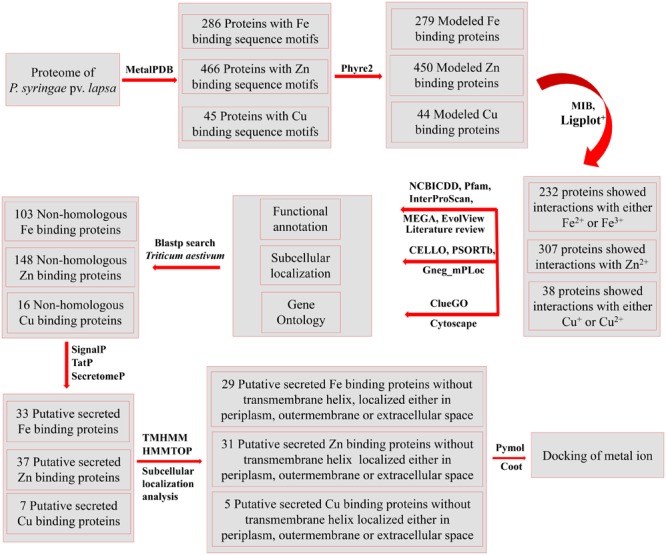
The overall methodology of the present study. The whole proteome of P. syringae pv. lapsa was analyzed for identification of metal (Fe, Zn, and Cu) binding sequence motifs using dataset of MetalPDB (Andreini et al., 2013) at e-value of 0.00001. The high throughout modeling of selected proteins was done by Phyre2 (Kelley et al., 2015) and selected models were analyzed for metal ion binding structural motifs using MIB (Lu et al., 2012) and Ligplot+ (Laskowski and Swindells, 2011). The functional annotation was done by InterProScan (Jones et al., 2014), Pfam (Finn et al., 2016), and NCBI-CDD (Marchler-Bauer et al., 2015). Clustering of the proteins were done by MEGA6 (Tamura et al., 2013) and EvolView (Zhang et al., 2012). The consensus of bioinformatics server CELLO (Yu et al., 2004), PSORTb (Yu et al., 2010), and Gneg-mPLoc (Shen and Chou, 2010) was used for subcellular localization of predicted metalloproteins. The Gene Ontology based biological function annotation networks were constructed by ClueGO (Bindea et al., 2009) and visualized by Cytoscape (Shannon et al., 2003). Blastp (Altschul et al., 1990) search was done against host proteome (Triticum aestivum) to identify non-homologous Fe, Zn, and Cu-binding proteins. Further, the putative secreted metal binding proteins were predicted by using SignalP (Petersen et al., 2011) TatP (Bendtsen et al., 2005) and SecretomeP (Bendtsen et al., 2004a) databases. The transmembrane analysis was done by TMHMM (Krogh et al., 2001) and HMMTOP (Tusnady and Simon, 2001) web servers. PyMol (DeLano, 2002) and Coot (Emsley and Cowtan, 2004) server were used for manual docking of metal ions and visualization of interactions.